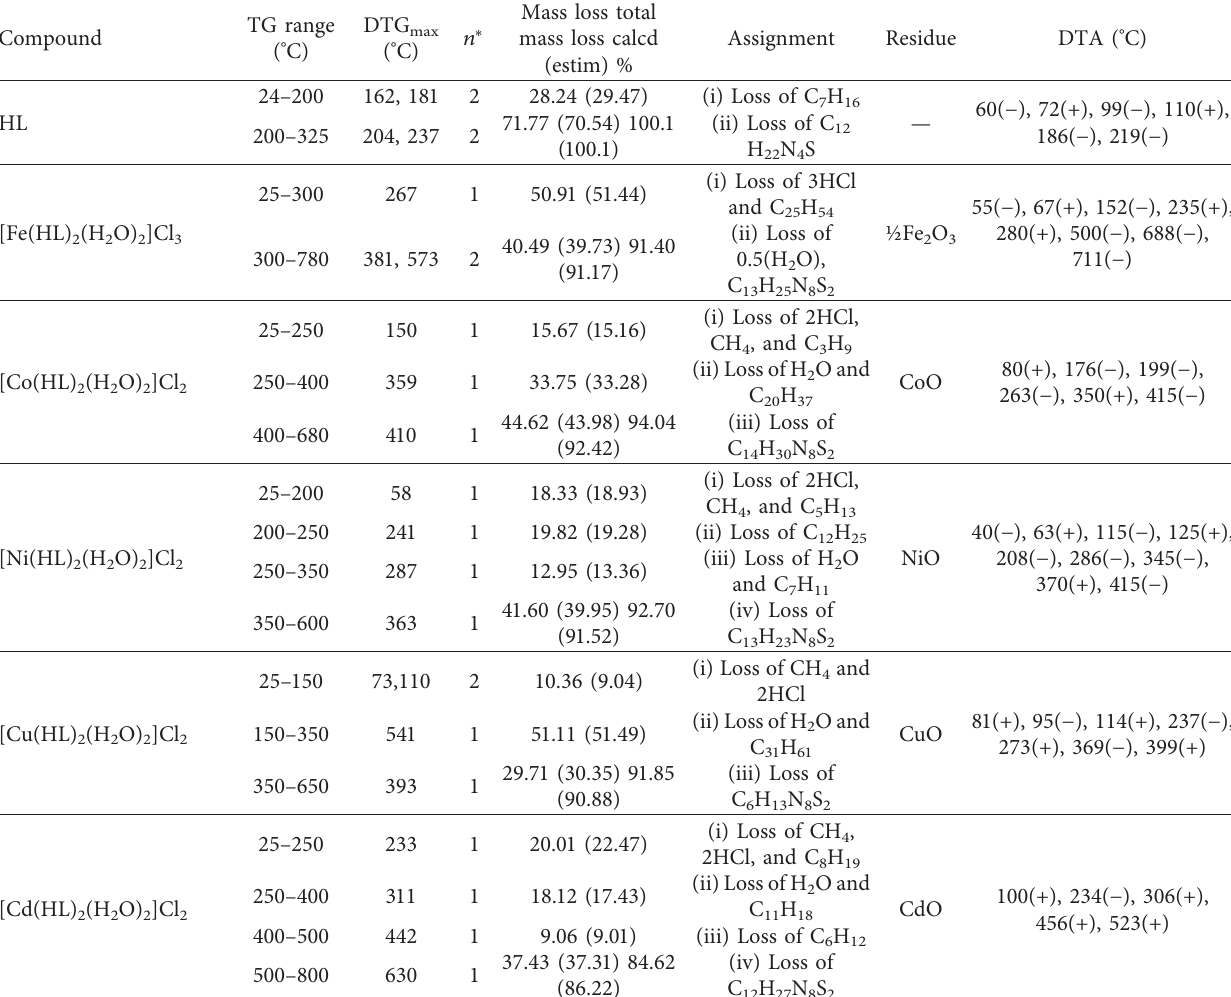
Table 2: Thermoanalytical results (TG and DTG) of triazole ligand and its metal complexes.